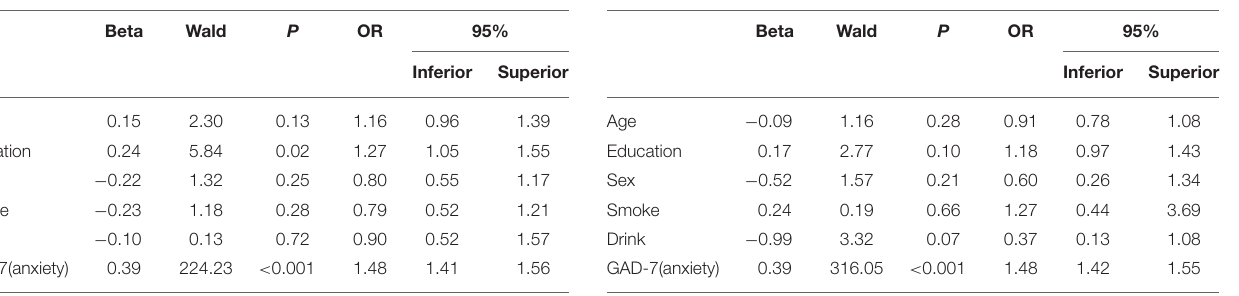
TABLE 6 | Influencing factors of insomnia in Doctor FL.